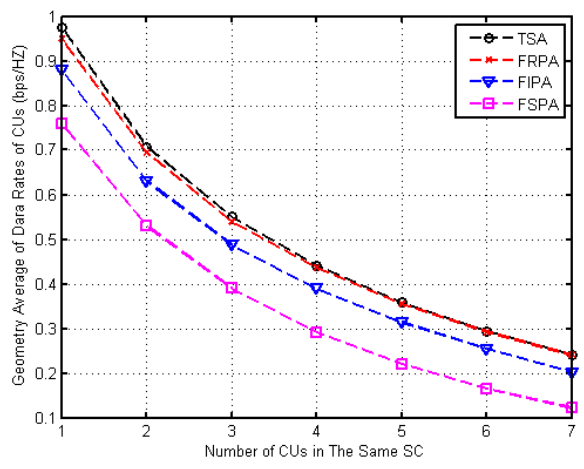
Figure 10. Geometry average of data rates versus number of CUs on the same SC. We study how the increasing of users impacts on the geometry average of data rates of CUs on each SC where the number of the users changes from 1 to 7.